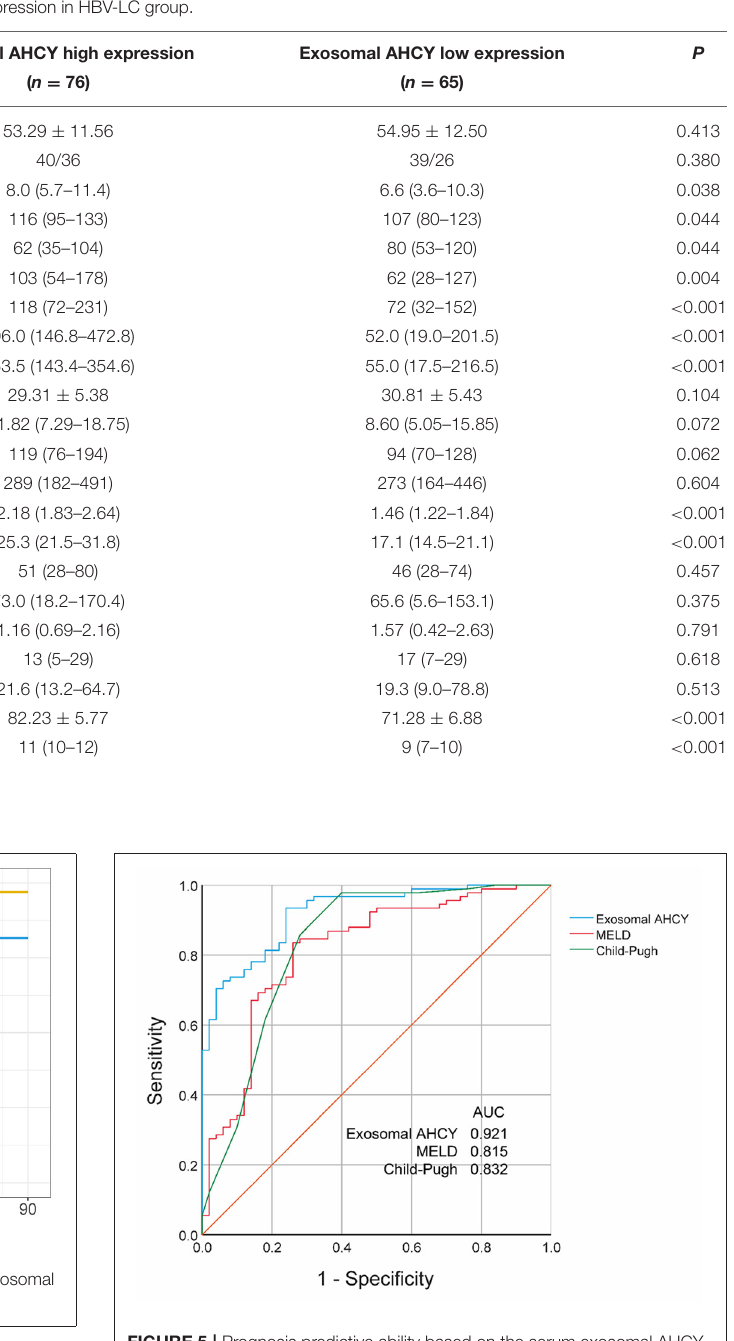
FIGURE 5 | Prognosis predictive ability based on the serum exosomal AHCY level in HBV-LC patients. In this study, exosomes in the serum samples from patients with CHB and HBV-LC were separated, and TEM, NTA, and Western blotting were used to identify the characteristics of the exosomes. Transmission electron microscopy showed that exosomes had an interconnected aggregated distribution in a clear background, a diameter of 100–200 nm, and